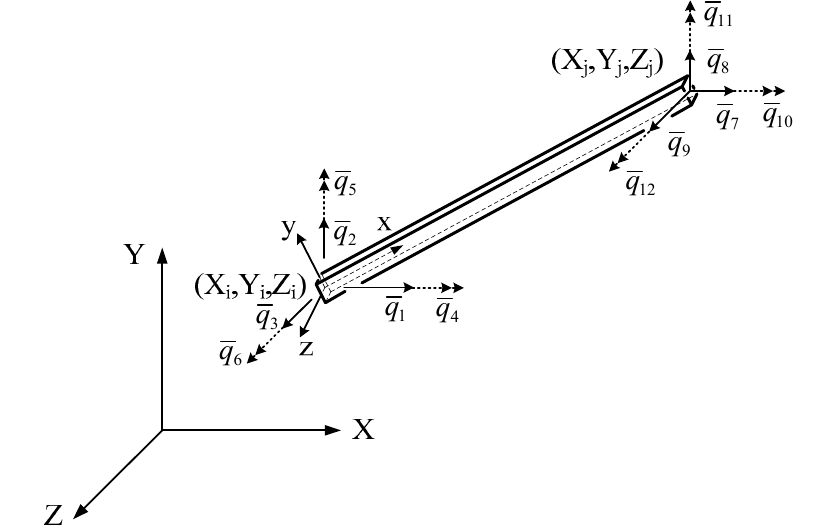
Figure A1. The element nodal displacement components in the global coordinate system.